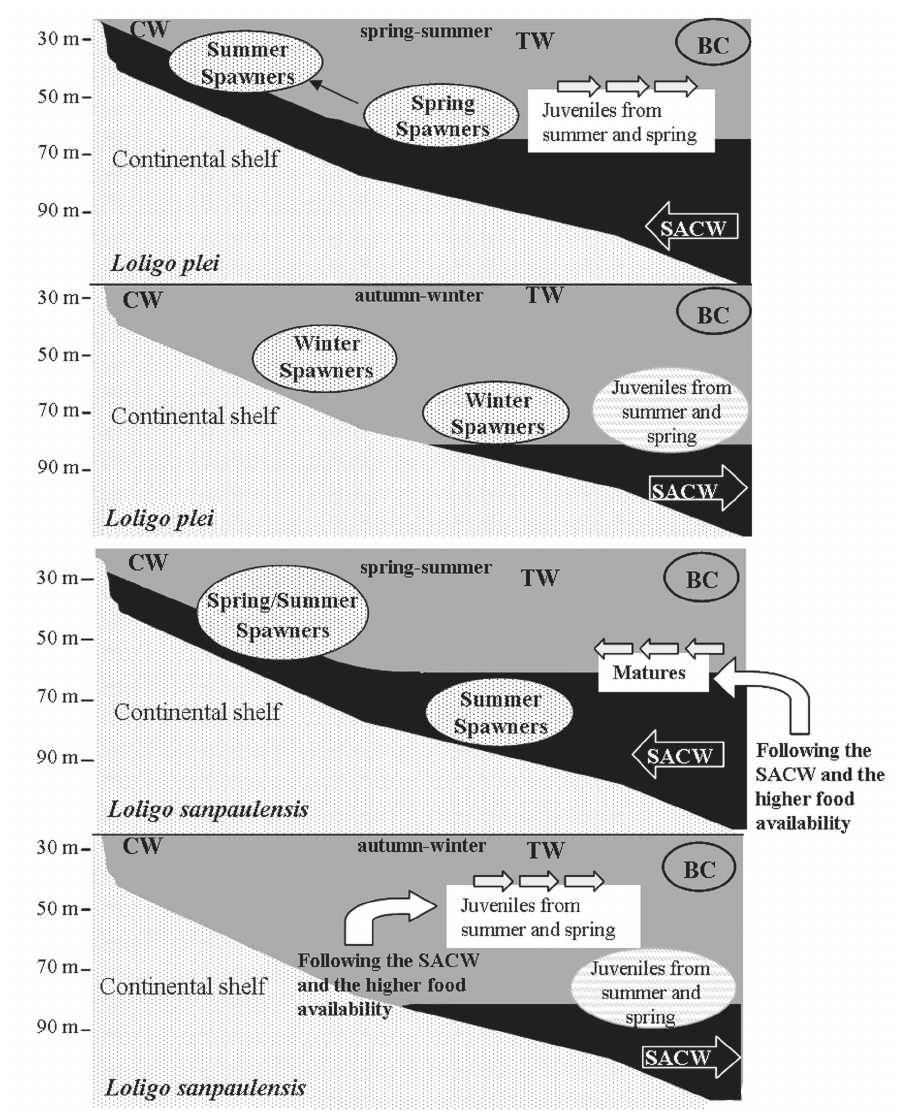
Fig. 10 . – Schematic diagrams of population displacement in different strata during spring-summer and autumn-winter of L. plei and L. sanpaulensis in the studied area. The dark zone indicates the intrusion and retreat of the South Atlantic Central Water (SACW). BC is the core of the Brazil Current; TW, Tropical Water and CW, Coastal